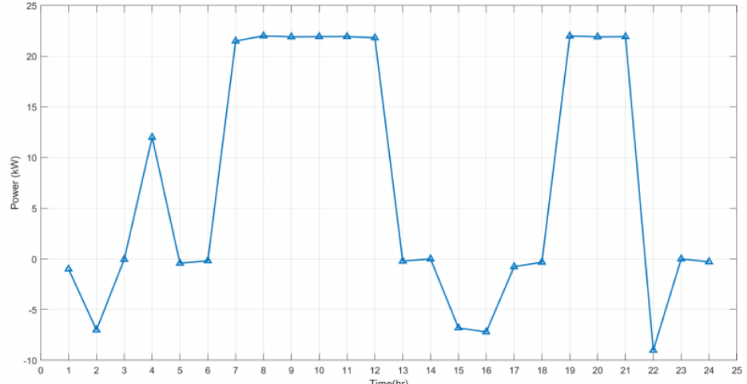
Figure 12. Charging and discharging operation of BESS in Scenario